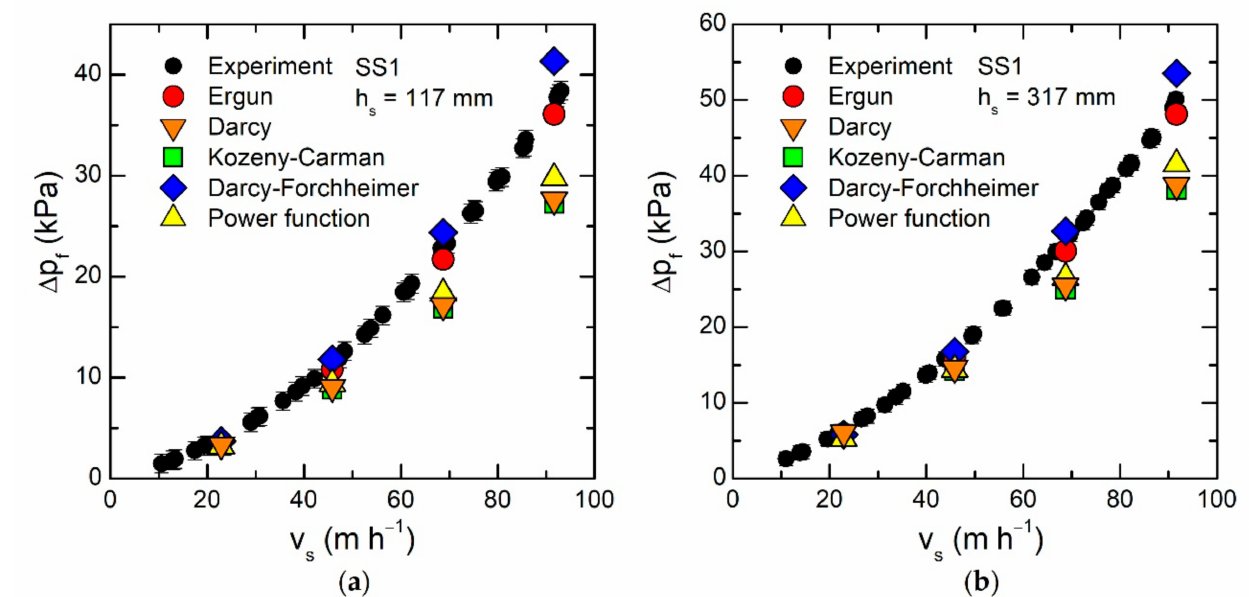
Figure 5. Filter pressure drop as a function of the superficial velocity experimentally observed and simulated using Equations (7)–(11) for the porous media (SS1) with sand height above the base plate equal to ( a ) h s = 117 mm; ( b ) h s = 317 mm.